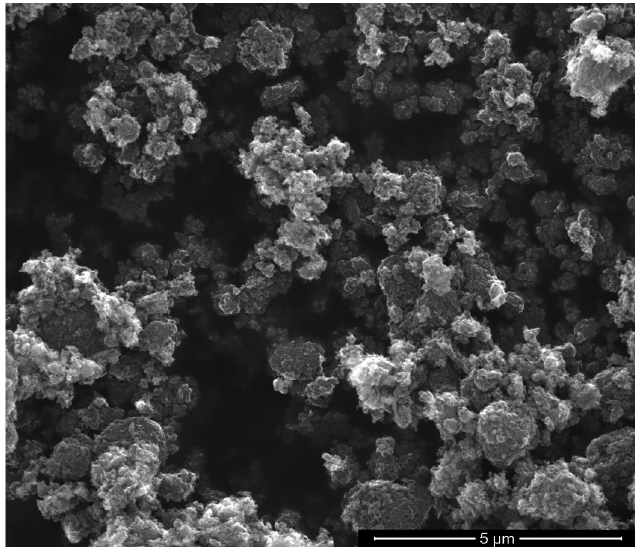
Figure 1. Scanning electron microscopy (SEM) micrograph of neat graphene nanoplatelets (GnP) powder.